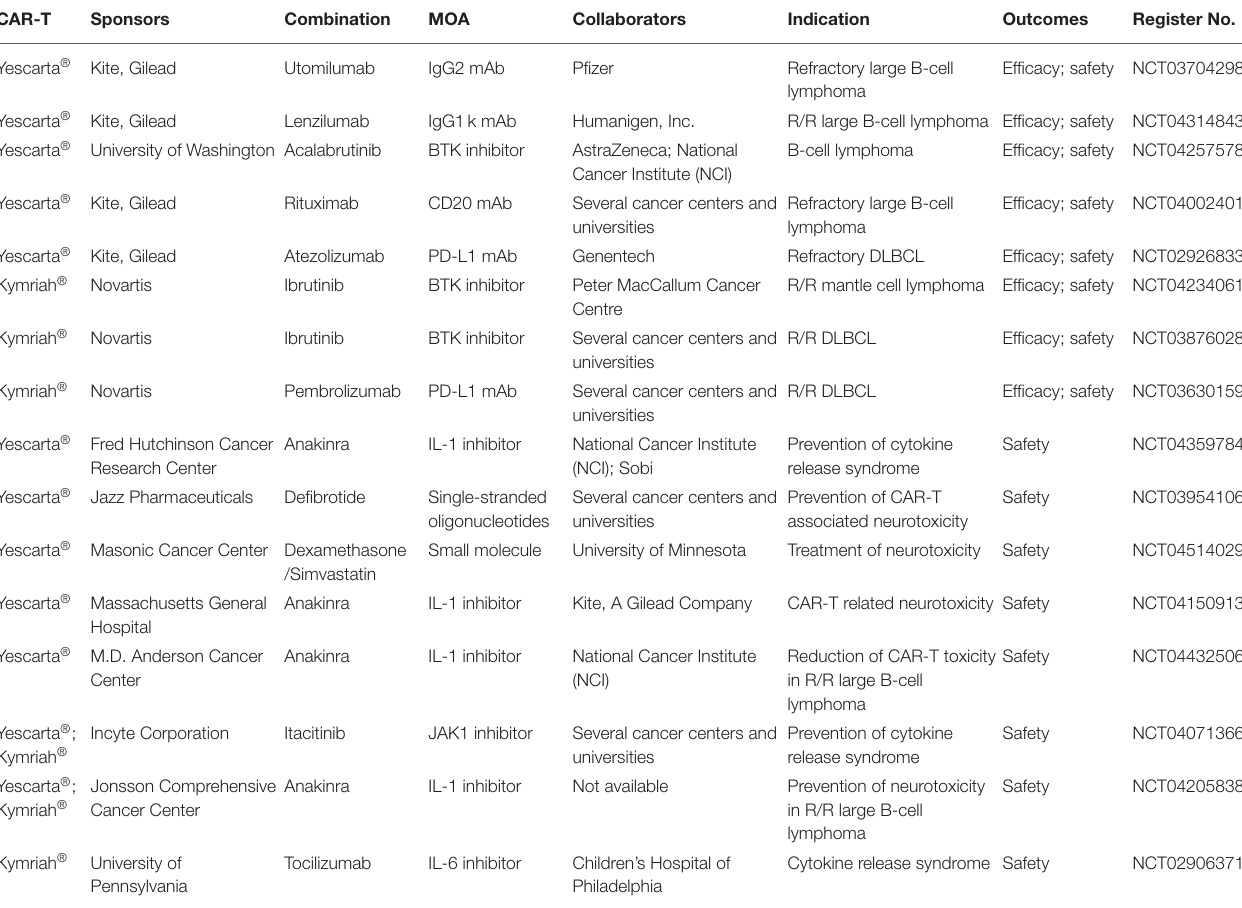
TABLE 2 | CAR-T cell therapies in combination with other products to improve efficacy or safety.